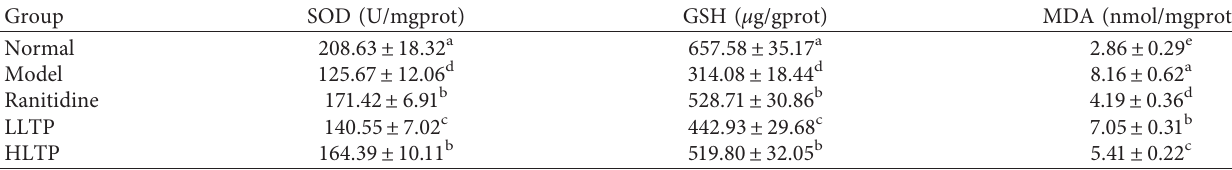
Table 6: SOD, GSH, and MDA levels in gastric tissue of mice with gastric